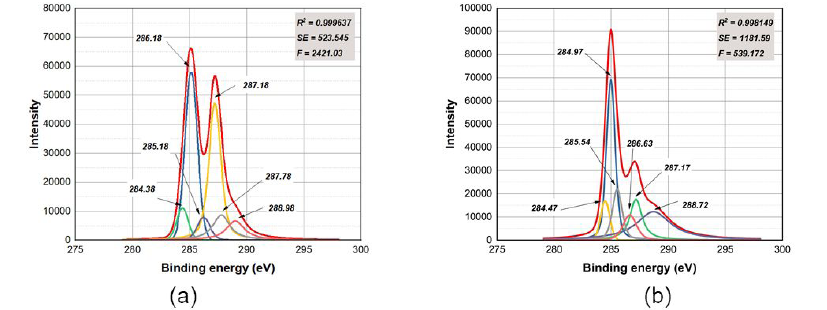
Figure 6. Deconvoluted spectra for high-resolution XPS C 1s peaks of: a) GO-2 and b)